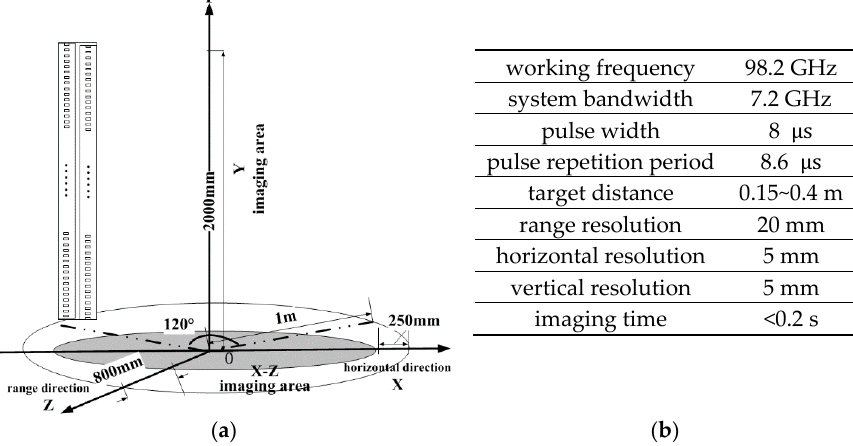
Figure 1. Terahertz imaging description. ( a ) The structure diagram of terahertz imaging system. ( b ) The working parameters of the imaging system, like working frequency, resolution and imaging time. The system images from original echo with fast back-projection. This method is a SAR imaging algorithm based on range frequency domain and azimuth time domain. Firstly, range compression